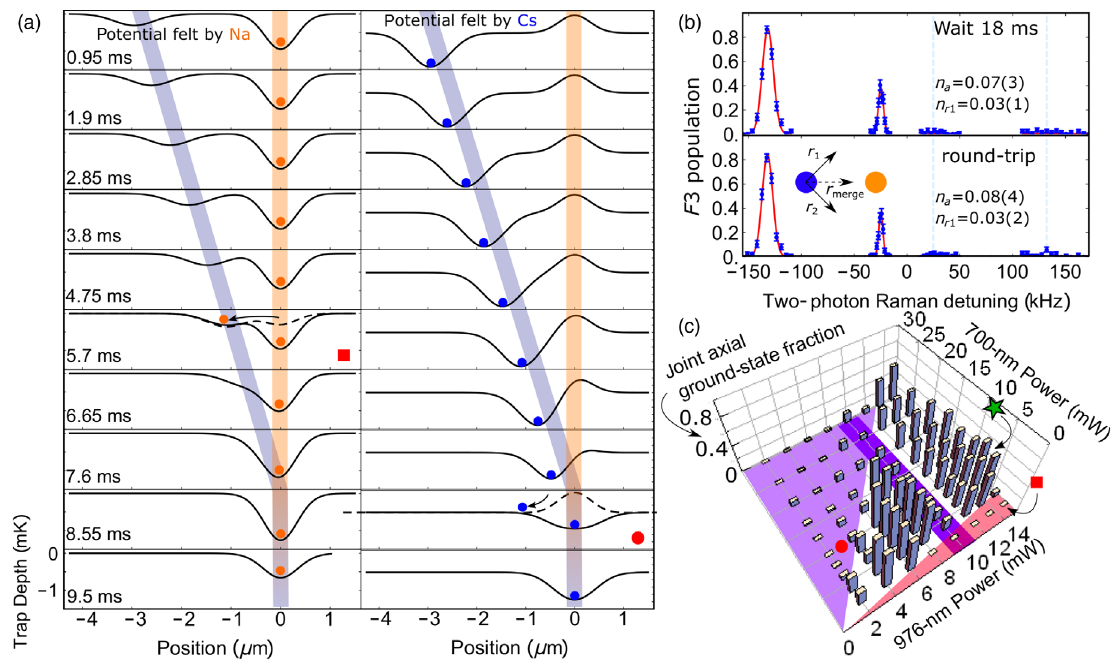
FIG. 3. Merging atoms in two tweezers while maintaining quantum motional states. (a) Radial cuts of optical potential experienced by Na andCsduringthemergetimesequence.Blueandorangelinesshowpathsofthe976-and700-nmtweezers,respectively.The976-nmtweezer containingCsistranslatedby 2 . 95 μ min7.6msuntilitoverlapswiththe700-nmtweezer.Then,the700-nmtweezerpowerislinearlyramped from48to0mWin1.5ms,followedbya 50 - μ swait.Dashedpotentialintheleft5.7-mspanel(markedbyredsquare)showstheconditionsfor nonideal tweezer powers, leading to spilling of Na. Dashed potential in the 8.55-ms panel (marked by red circle) shows the conditions for a differentsetofnonidealtweezerpowersgivingrisetoantitrappingforCs.(b)Ramansidebandspectroscopytocharacterizeheatingassociated with atom transport. Top: A control experiment holding the atoms stationary for 18 ms. Bottom: After the round-trip merge sequence [the sequence shown in (a) followed by its time reverse]. Dashed blue lines indicate expected position of Δ n ¼ − 1 sidebands. The round-trip sequence causes minimal heating. Inset: Coordinates of the transport direction versus a thermometry axis. Blue and orange circles represent 976- and 700-nm tweezers, respectively. (c) Na þ Cs joint axial ground-state fraction after round-trip merge sequence as a function of 700- and 976-nm tweezer powers. The lower triangle in red corresponds to spilling of Na. Red square is an exemplary point in this regime, whose radial potential is plotted with a dashed line in the correspondingly marked panel in (a). Upper triangle in purple indicates antitrapping of Cs. Red circle is an exemplary point, whose potential is plotted with a dashed line in the correspondingly marked panel in (a). Dark purple stripe shows parametric heating resonance (due to technical imperfection) during transport of Cs. Our usual operating point is indicated by the